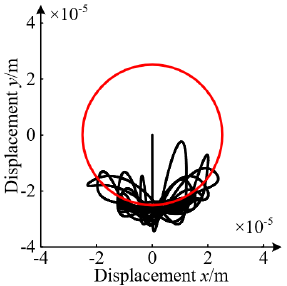
Figure 12. Axial trajectory under upper unit failure.